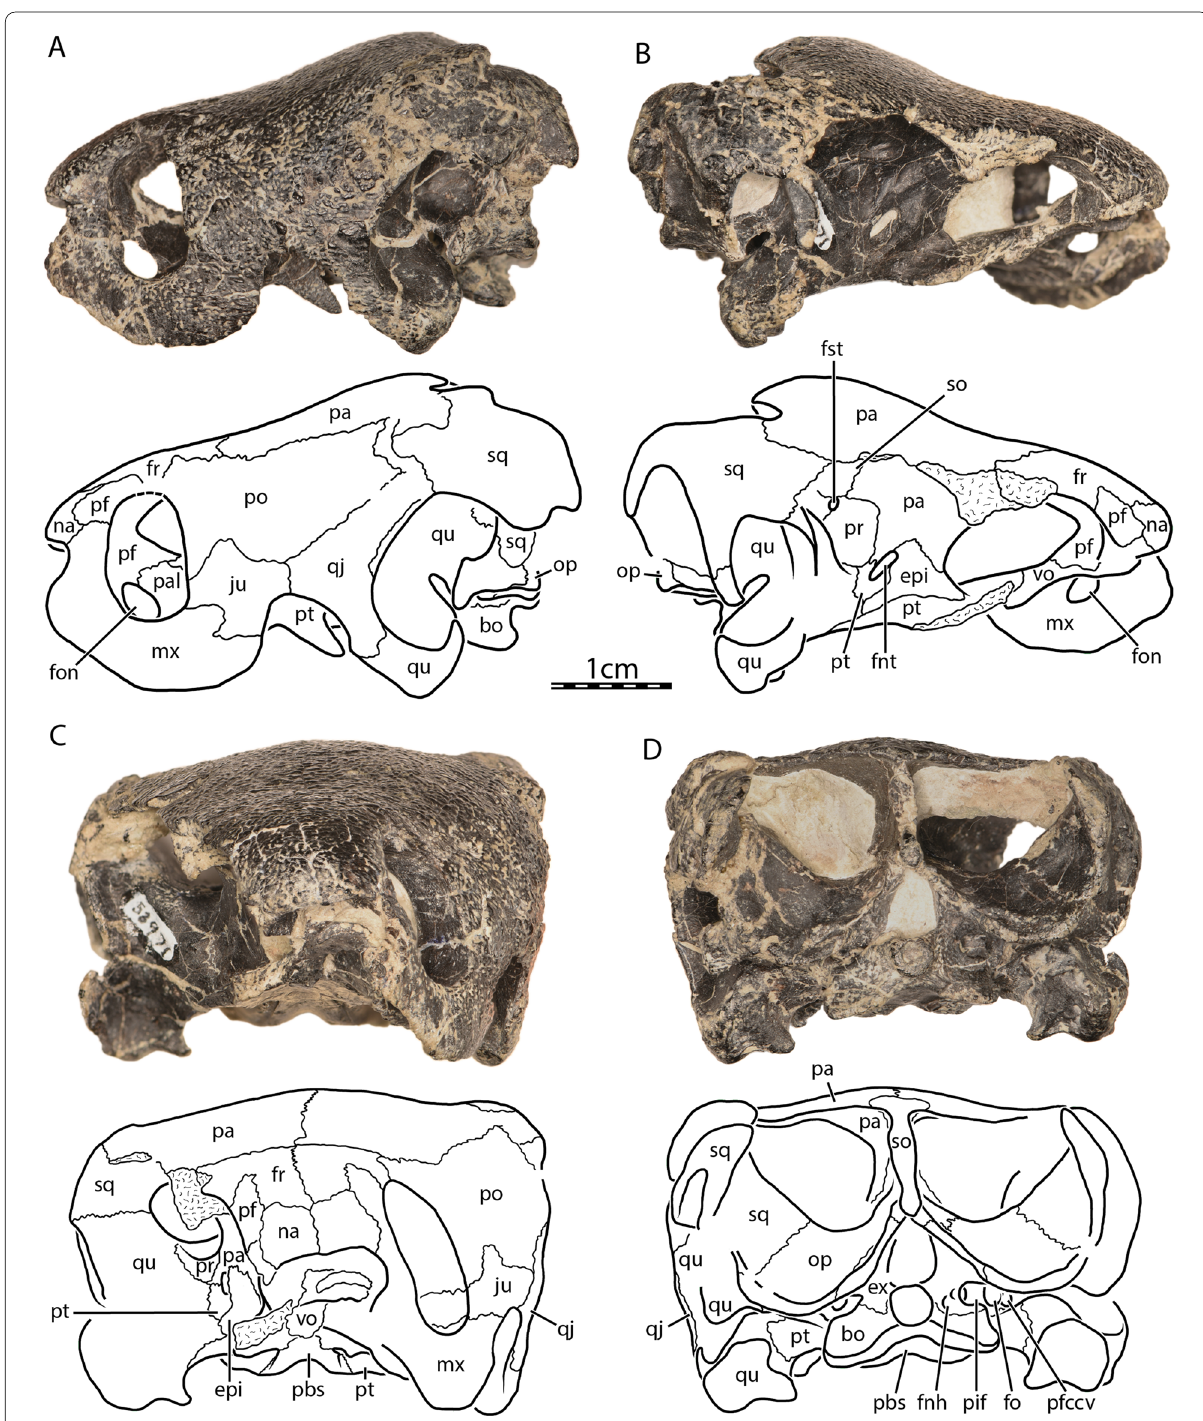
Fig. 2 Uluops uluops , UCM 53971, Late Jurassic (Tithonian) of Wyoming, U.S.A. Photographs and illustrations of skull in A left lateral, B right lateral, C anterior, and D posterior views. bo basioccipital, epi epipterygoid, ex exoccipital, fnh foramen nervi hypoglossi, fnt foramen nervi trigemini, fo fenestra ovalis, fon foramen orbito-nasale, fr frontal, fst foramen stapedio-temporale, ju jugal, mx maxilla, na nasal, op opisthotic, pa parietal, pal palatine, pbs parabasisphenoid, pf prefrontal, pfccv posterior foramen for the canalis cavernosus, pif processus interfenestralis of the opisthotic, po postorbital, pr prootic, pt pterygoid, qj quadratojugal, qu quadrate, so supraoccipital, sq squamosal, vo